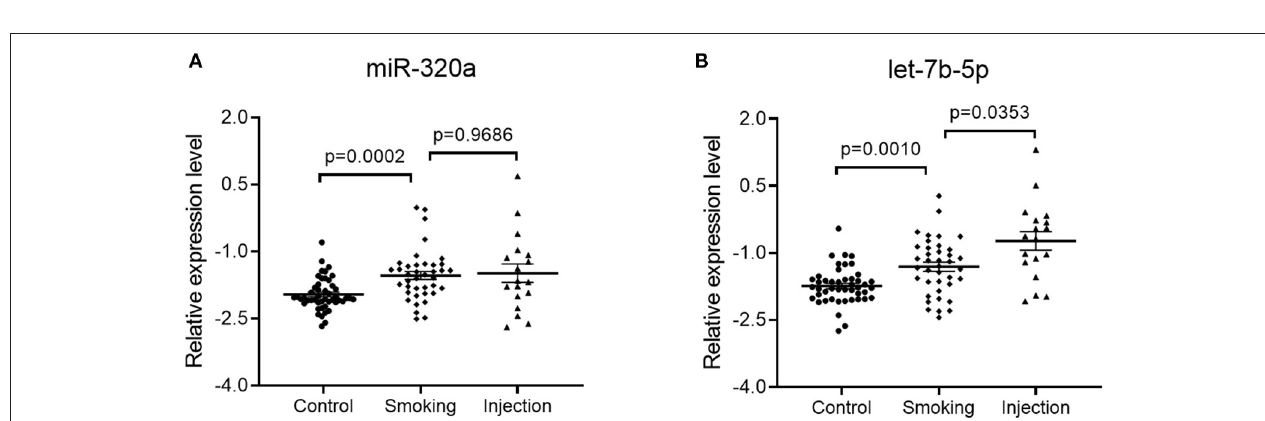
FIGURE 5 | Impact of administration routes on the plasma miRNA expression level. Plasma specimens were collected from healthy controls ( n = 46), heroin smoking patients ( n = 39), and heroin injection patients ( n = 18) enrolled in the training and validation sets. Statistical significance was calculated by Welch’s ANOVA test followed by a Games-Howell post-hoc test for multiple comparisons. (A) Relative expression levels of miR-320a; Control group vs. smoking group, adjusted p -value = 0.0002; Smoking group vs. injection group, adjusted p -value = 0.9686; (B) Relative expression levels of let-7b-5p; Control group vs. smoking group, adjusted p -value = 0.001; Smoking group vs. injection group, adjusted p -value = 0.0353. Data are shown as scatter plots. Mean values are indicated by horizontal